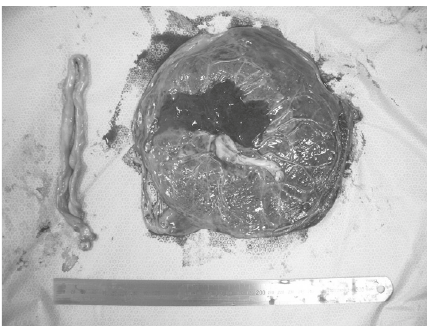
Figure 2: Macroscopic view of the placenta in Case 8 at delivery, showing marginal irregular traces of bleeding under the broken amniotic membrane.